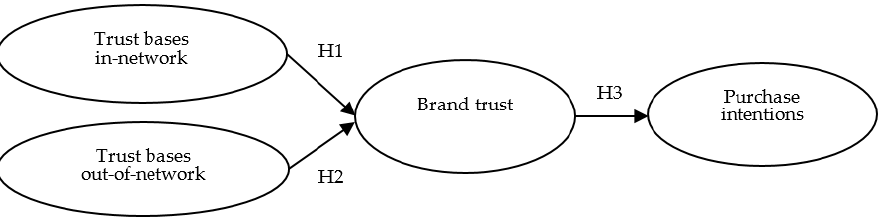
Figure 1. Structure model of the study. Hypothesis 1 (H1). Consumers’ trust bases in the social network positively influence their trust in the biotech industry